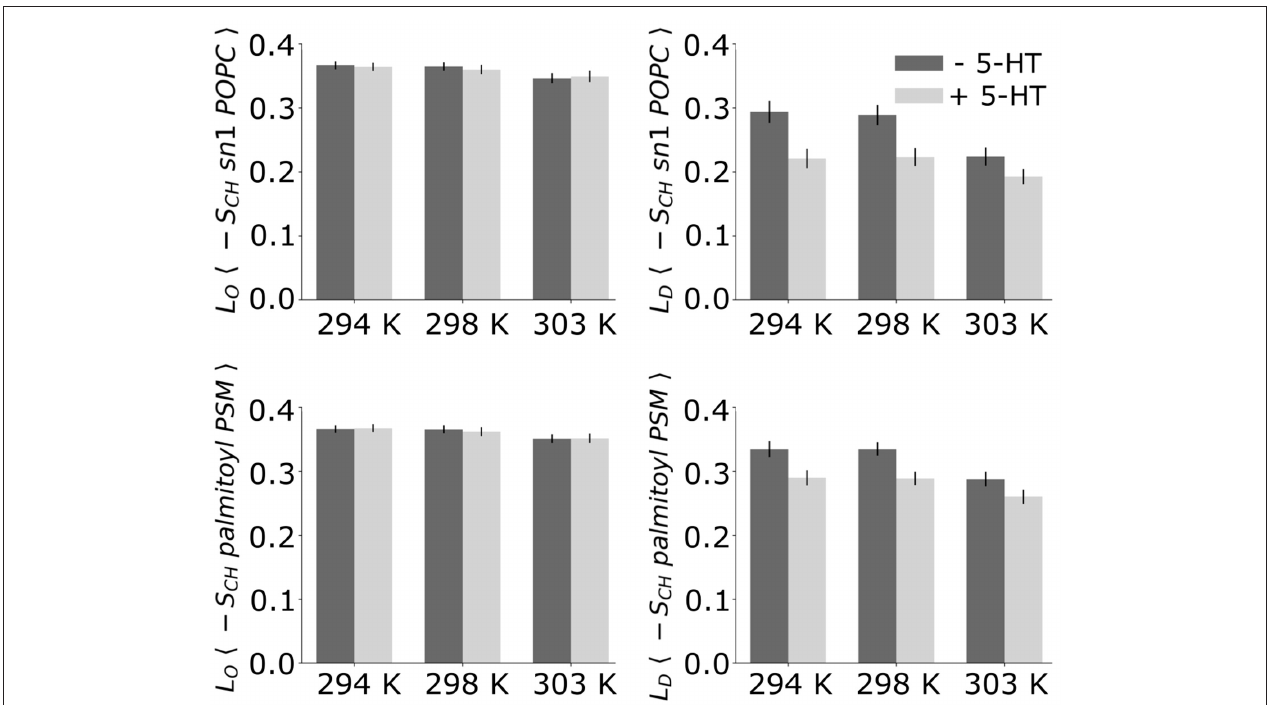
FIGURE 4 | Average deuterium order parameters. Given are the deuterium order parameters averaged over the palmitoyl chain of POPC (Top) and the palmitoyl chain of PSM (Bottom) without ( dark bars ) and with serotonin ( light bars ).